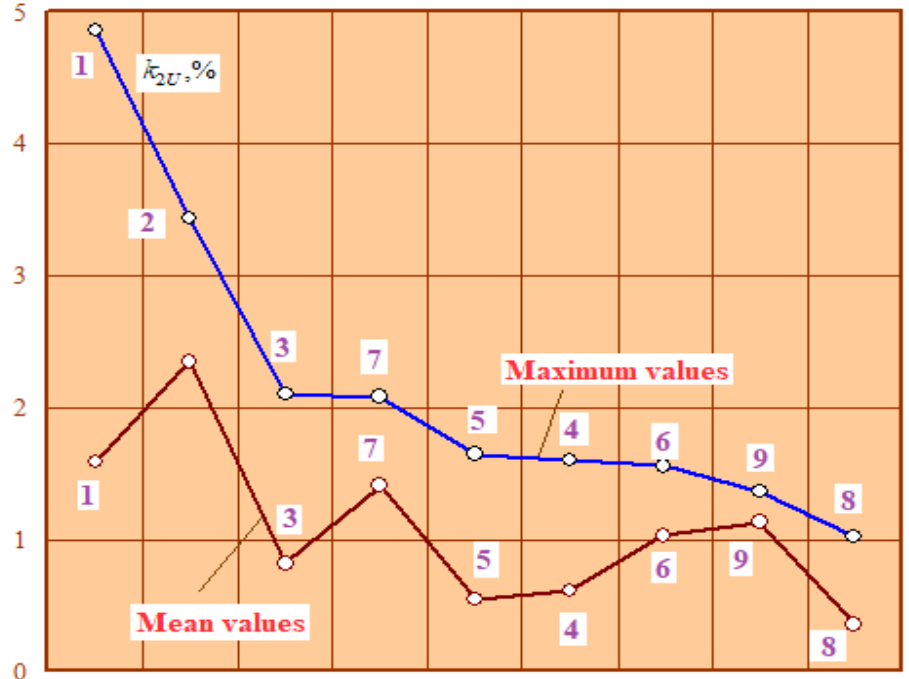
Figure 16. Negative-sequence unbalance ratios at 220 kV buses of TS 4—callout numbers correspond Figure 16. Negative - sequence unbalance ratios at 220 kV buses of TS 4—callout numbers corre- to those in Figure spond to those in Figure 16.